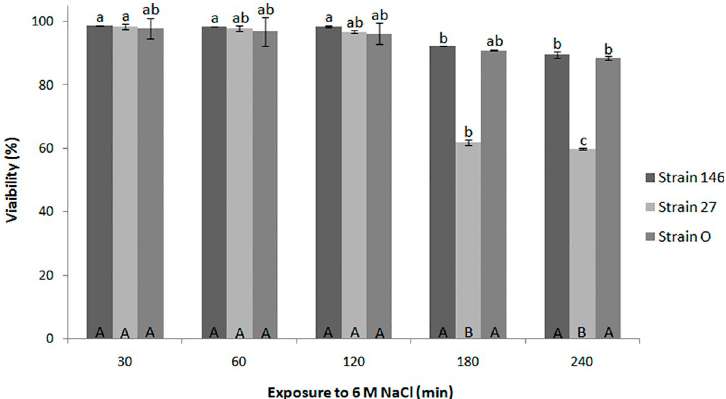
Fig 3. Survival of yeast strains after temporary exposure to 6 M NaCl solution. Statistical evaluation as for Fig 1. Lowercase letters again correspond to the comparison between a strain and the respective control. Uppercase letters represent comparisons between yeasts at the specific conditions.